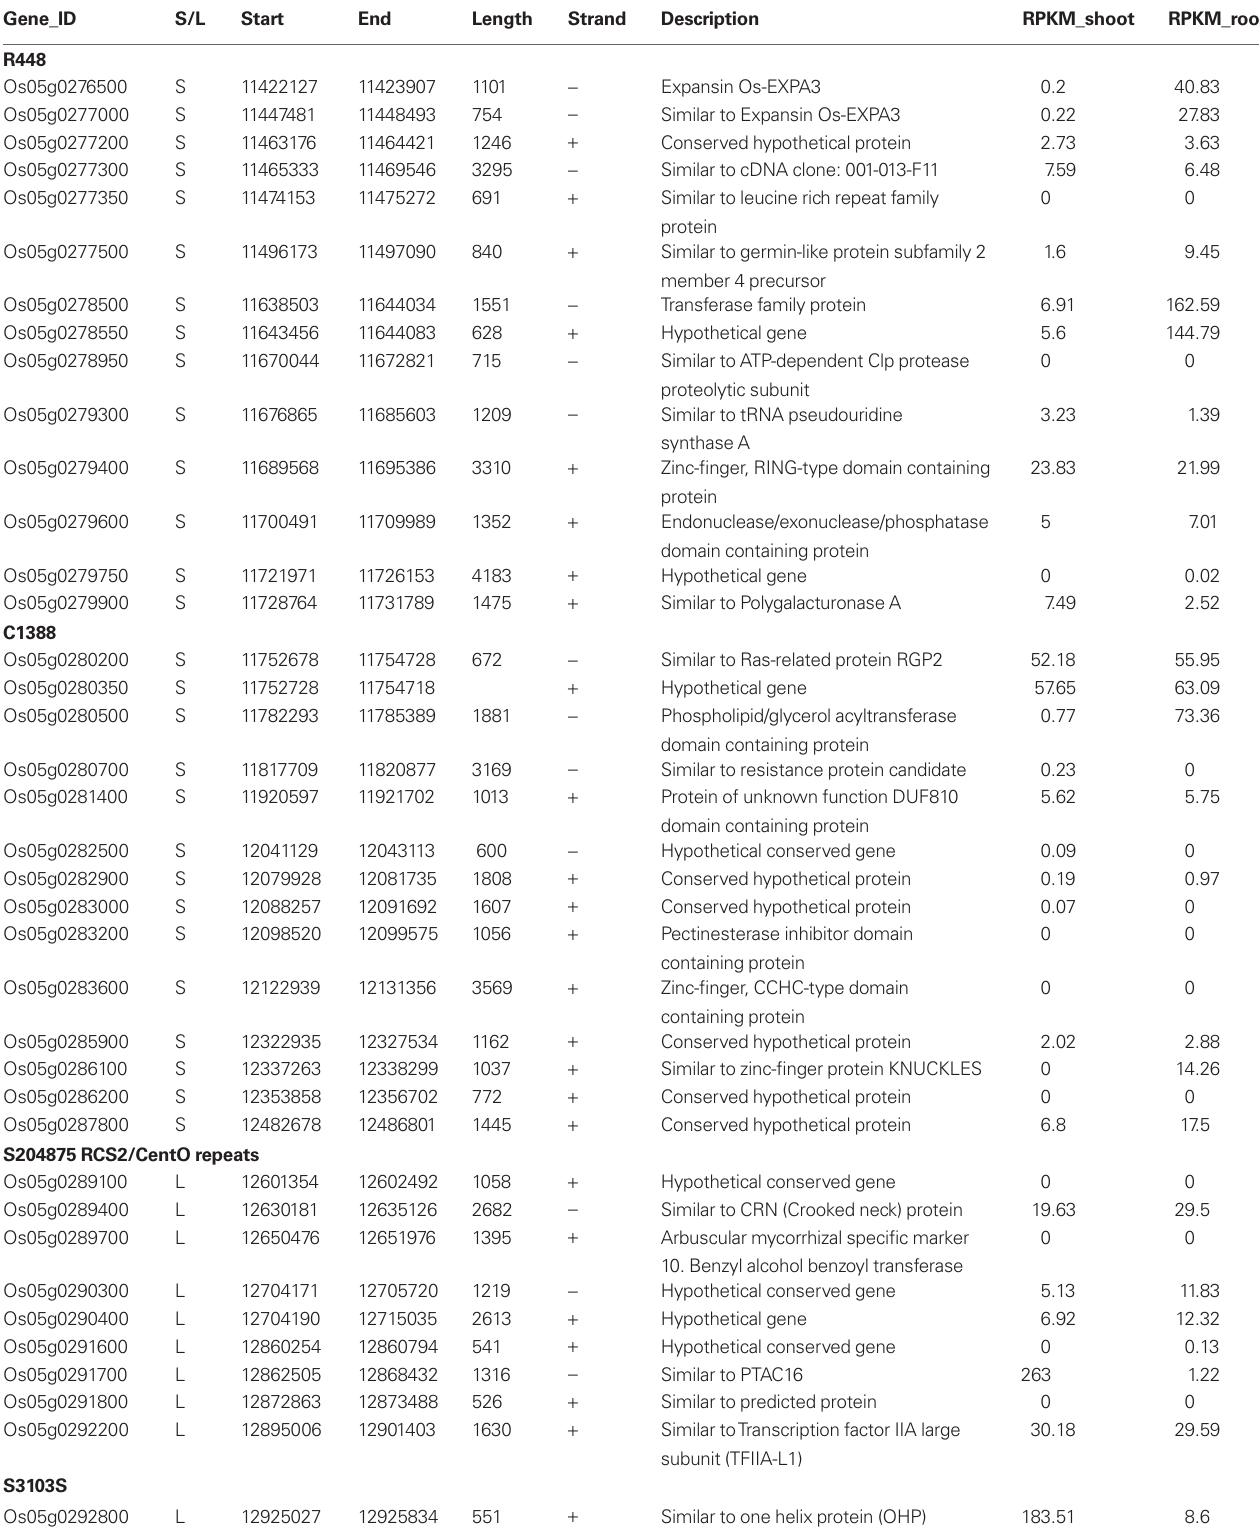
Table A1 | Annotated genes in Cen5